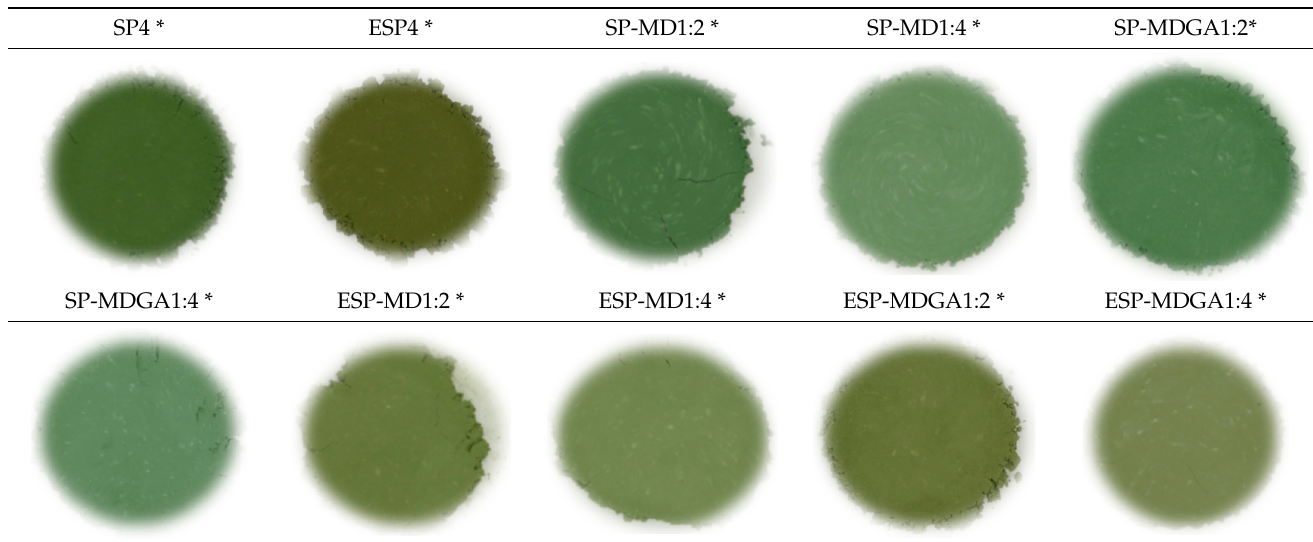
Table 2. Colour intensities of powder samples.